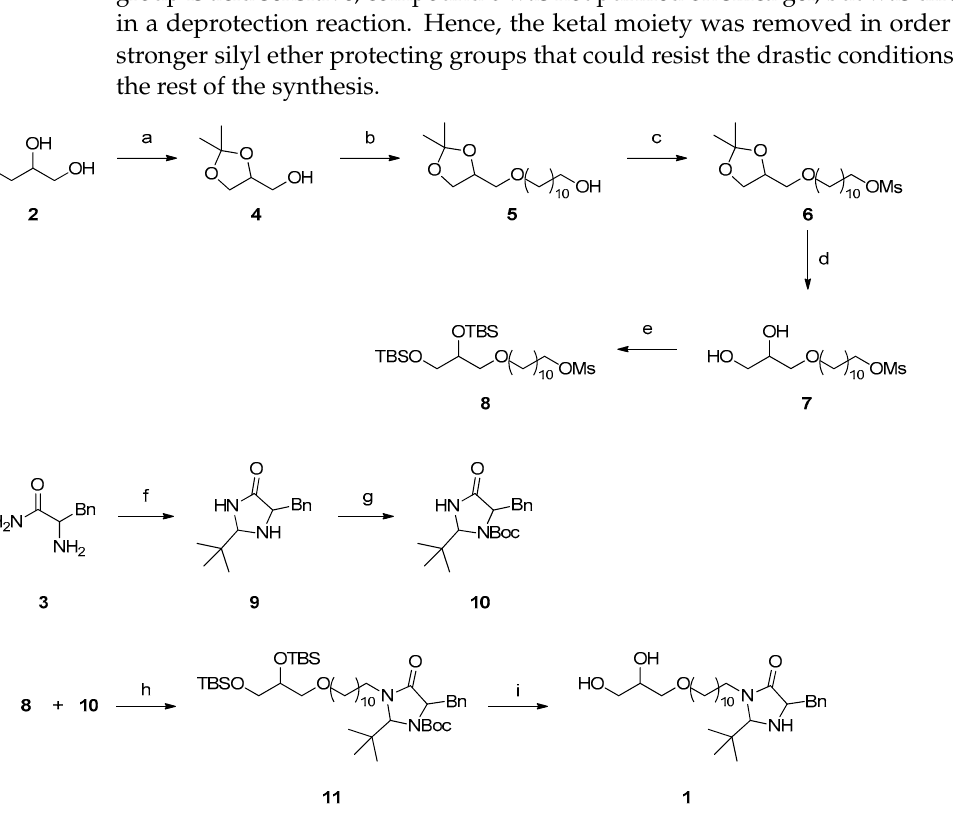
Figure 2. Total synthesis of the surfactant. ( a ) Montmorillonite K10 (20%w:w), acetone, RT, 3 h, 98%, ( b ) Br(CH 2 ) 11 OH, NaOH, 4-MTHP, 80 ◦ C, 5 h, 58%, ( c ) MsCl, TEA, MTHP, 0 ◦ C, 3 h, 68%, ( d ) p TSA, MeOH, RT, overnight, 88%, ( e ) TBSCl, Imidazole, THF, RT, overnight, 88%, ( f ) pivaldehyde, FeCl 3 , THF, 65 ◦ C, 24 h, 86%, ( g ) Boc 2 O, DCM, RT, overnight, 91%, ( h ) NaH (60% dispersed in oil), DMF, 60 ◦ C, 8 h, 22%, ( i ) TFA, DCM, RT, overnight then TBAF, THF, RT, 5 h,